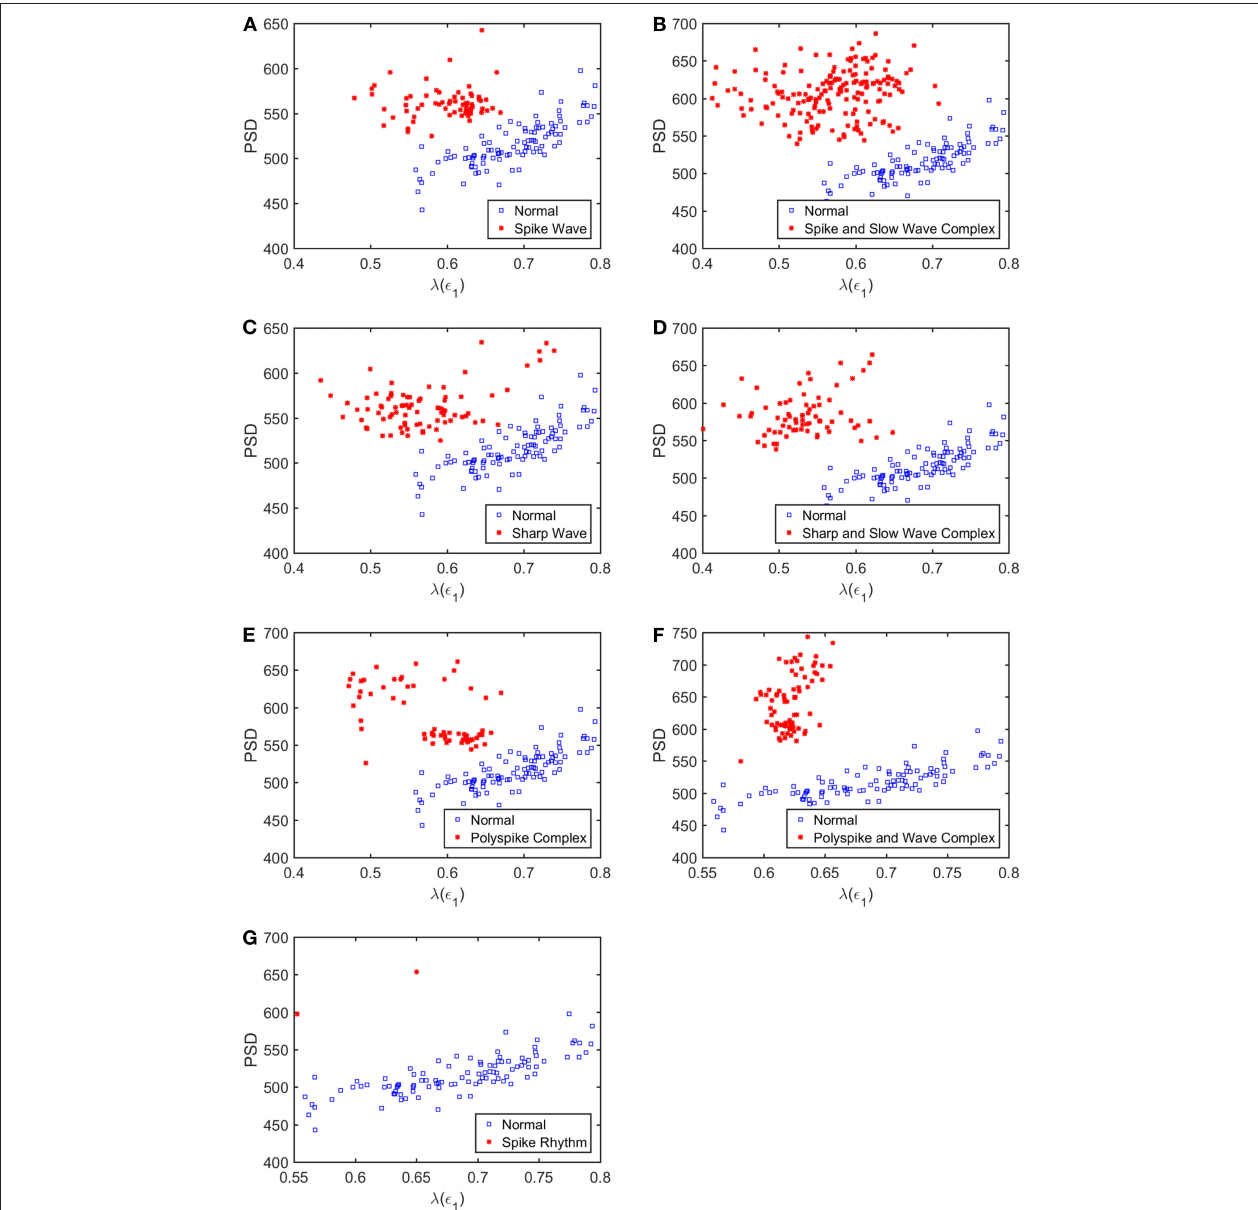
FIGURE 5 | Scatter plots with PSD and λ (e1), where (A–G) , illustrates the different between the seven types of epileptiform discharges (spike wave, spike and slow wave complex, sharp wave, sharp and slow wave complex, polyspike complex, polyspike and slow wave complex, spike rhythm discharges) and normal EEG. These plots highly suggest the classification accuracy will be very